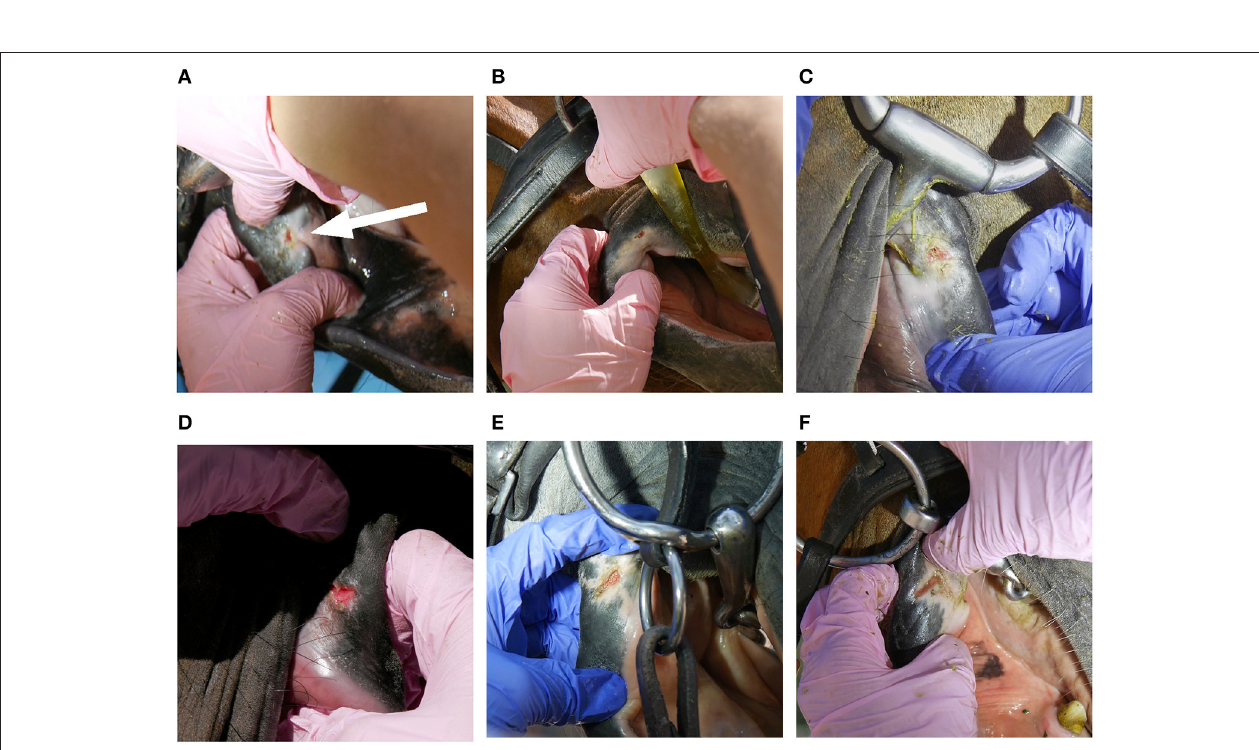
FIGURE 3 | Bit-related outer lip commissures lesions; (A) wound 4 points, Arrow: abnormal appearance of lip commissure due to old bit-related lesion. (B) Wound 4 points (C) wound 4 points (D) wound 6 points (E) wound 6 points (F) wound 6 points.